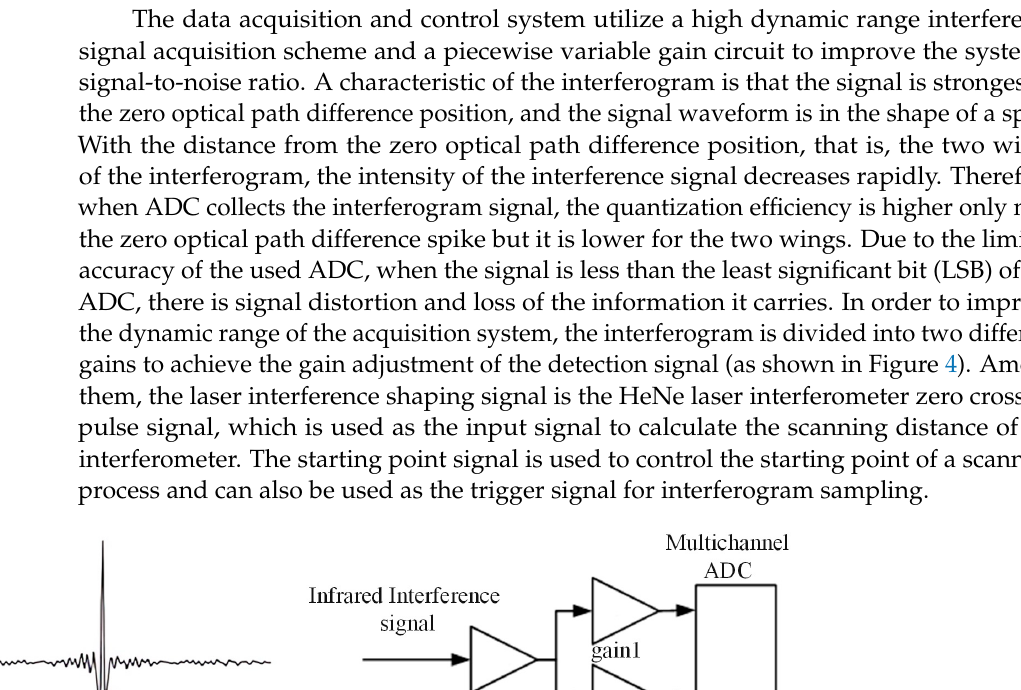
Figure 5. The three-dimensional model diagram of HRFTS structure ( left figure) and real object ( right figure). 3. Calibration The factors affecting the detection capability of greenhouse gases mainly include ab- sorption spectral sensitivity, instrument spectral resolution, etc. After the spectrometer is developed, its basic performance needs to be tested and characterized to provide basic data for subsequent applications. A long optical path gas absorption cell was used to test the sensitivity of the greenhouse gas absorption spectrum, and a hyperspectral tunable laser scanning system was used to test the Instrument Line Shape (ILS).